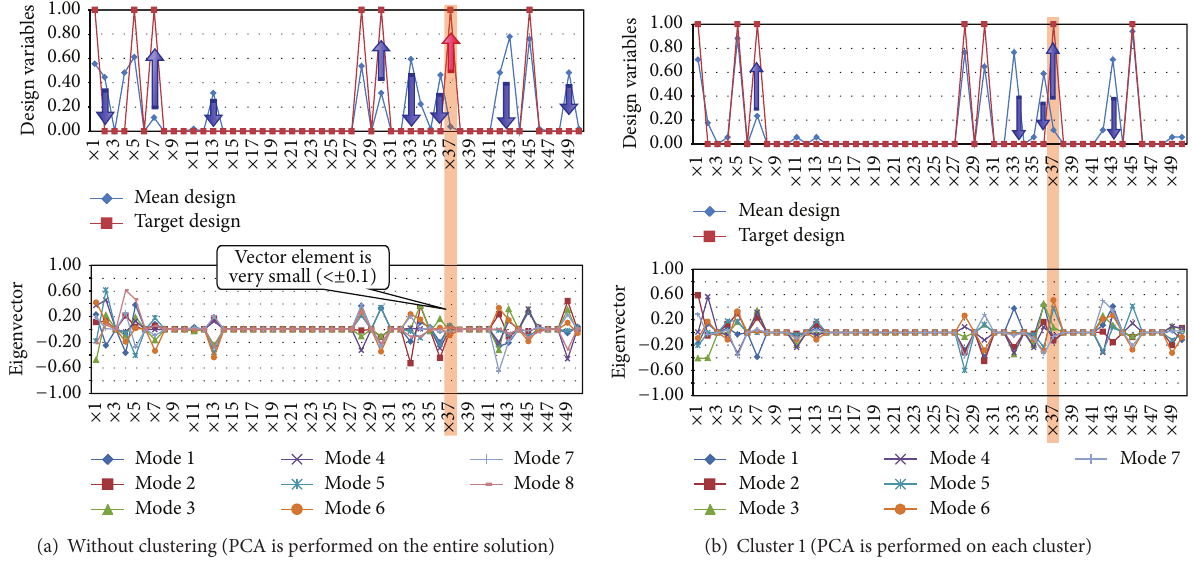
Figure 9: Distribution of eigenvectors in design approximation of max solution.